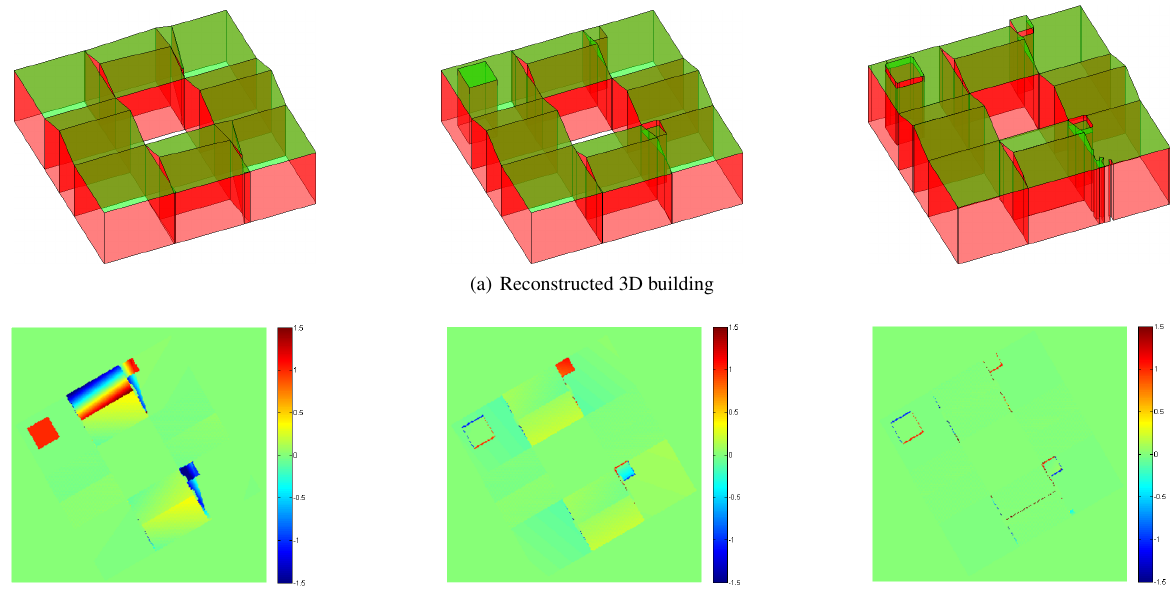
Figure 9. Results of the building reconstruction concerning the DSM in Fig. 2(a). Left column: Results with line continuation, cut lines and multiple building agglomeration; middle column: Results by using additional step lines; right column: Polygon based results using cut lines and step lines and a single building